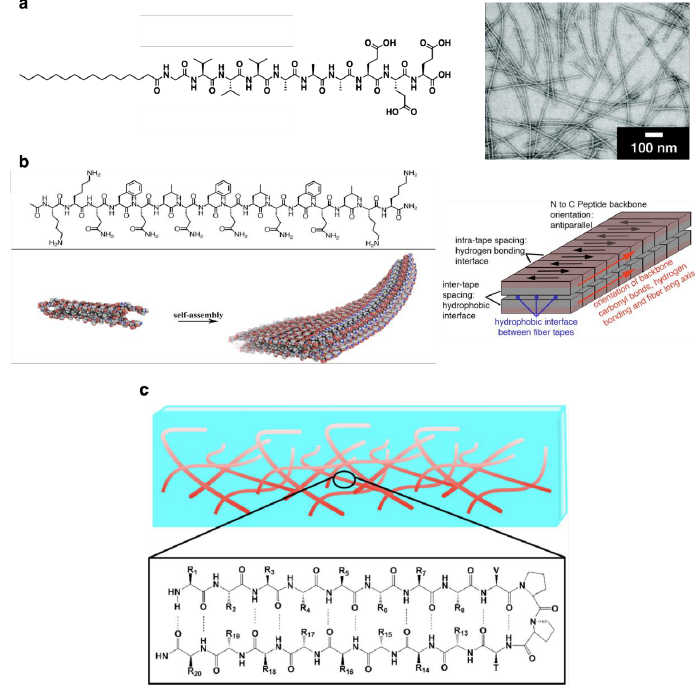
Figure 2. Representative self-assembled peptide-based fibers. ( a ) Peptide fibers composed of peptide amphiphiles. ( b ) Double domain-type peptide fibers containing alternate hydrophobic and hydrophilic amino acids for self-assembly. ( c ) Peptide fibers composed of β -hairpin peptide structures. Reprinted with permission from refs 3 ( a ), 42 ( b ), and 59 ( c ). Copyright 2008 American Chemical Society ( a ), 2013 American Chemical Society ( b ), and 2017 American Chemical Society ( c ).